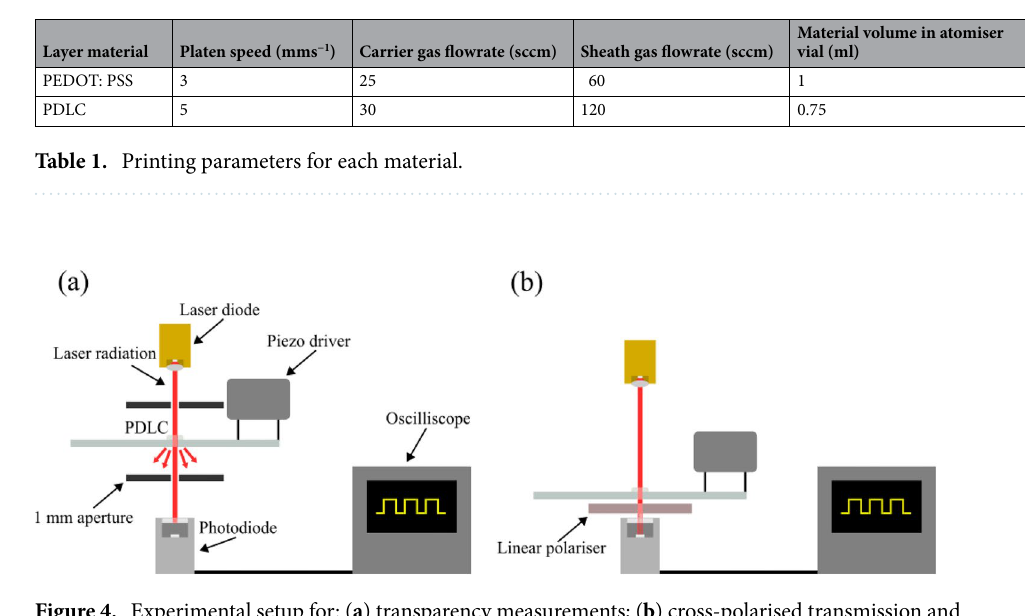
Figure 4. Experimental setup for: ( a ) transparency measurements; ( b ) cross-polarised transmission and relaxation time